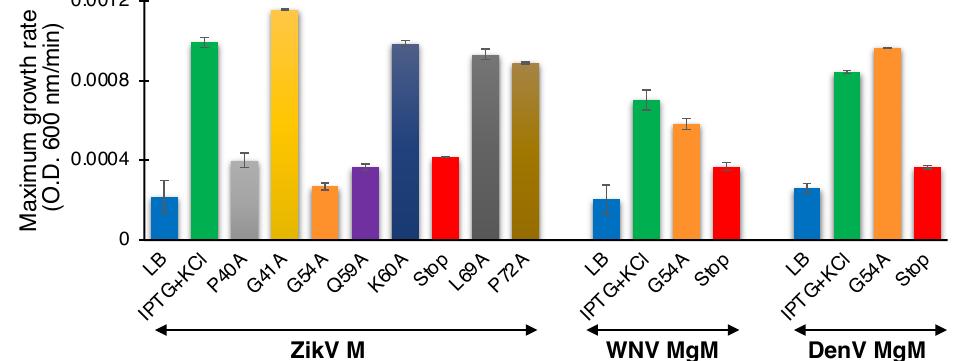
Figure 5. Effect of mutants of flavivirus membrane proteins in the positive genetic assay. Maximal growth rates of K + -uptake deficient bacteria that express mutants of ZikV-M, WNV MgM, and DenV MgM grown with 10µM